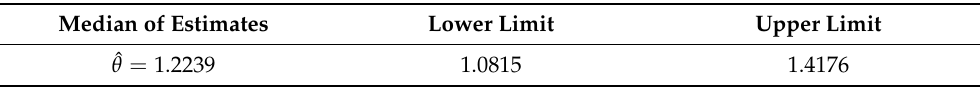
Table 9. The median of bootstrap estimators and bootstrap confidence intervals. Median of Estimates